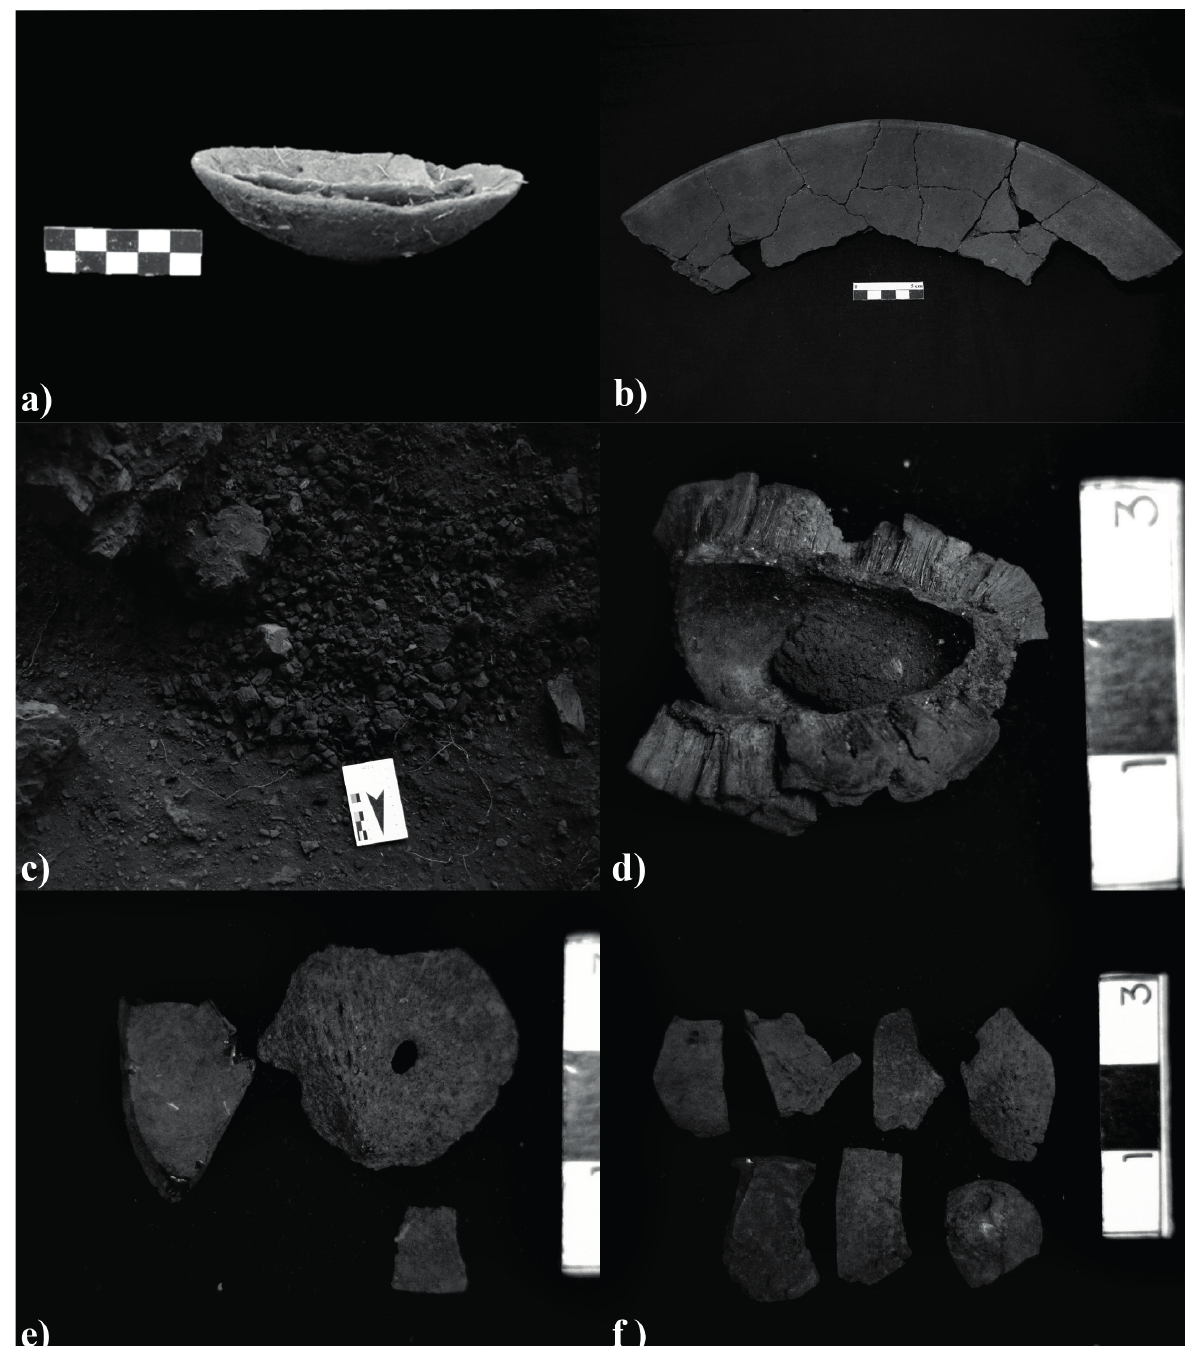
Figure 4 - Archaeological and botanical fragments recorded in sites in Serra de Carajás. a and b ) ceramic artifacts; c ) fire structure; d ) seeds Caryocar sp.; e and f ) seeds of Arecaceae. Source: Projeto arqueológico Carajás -